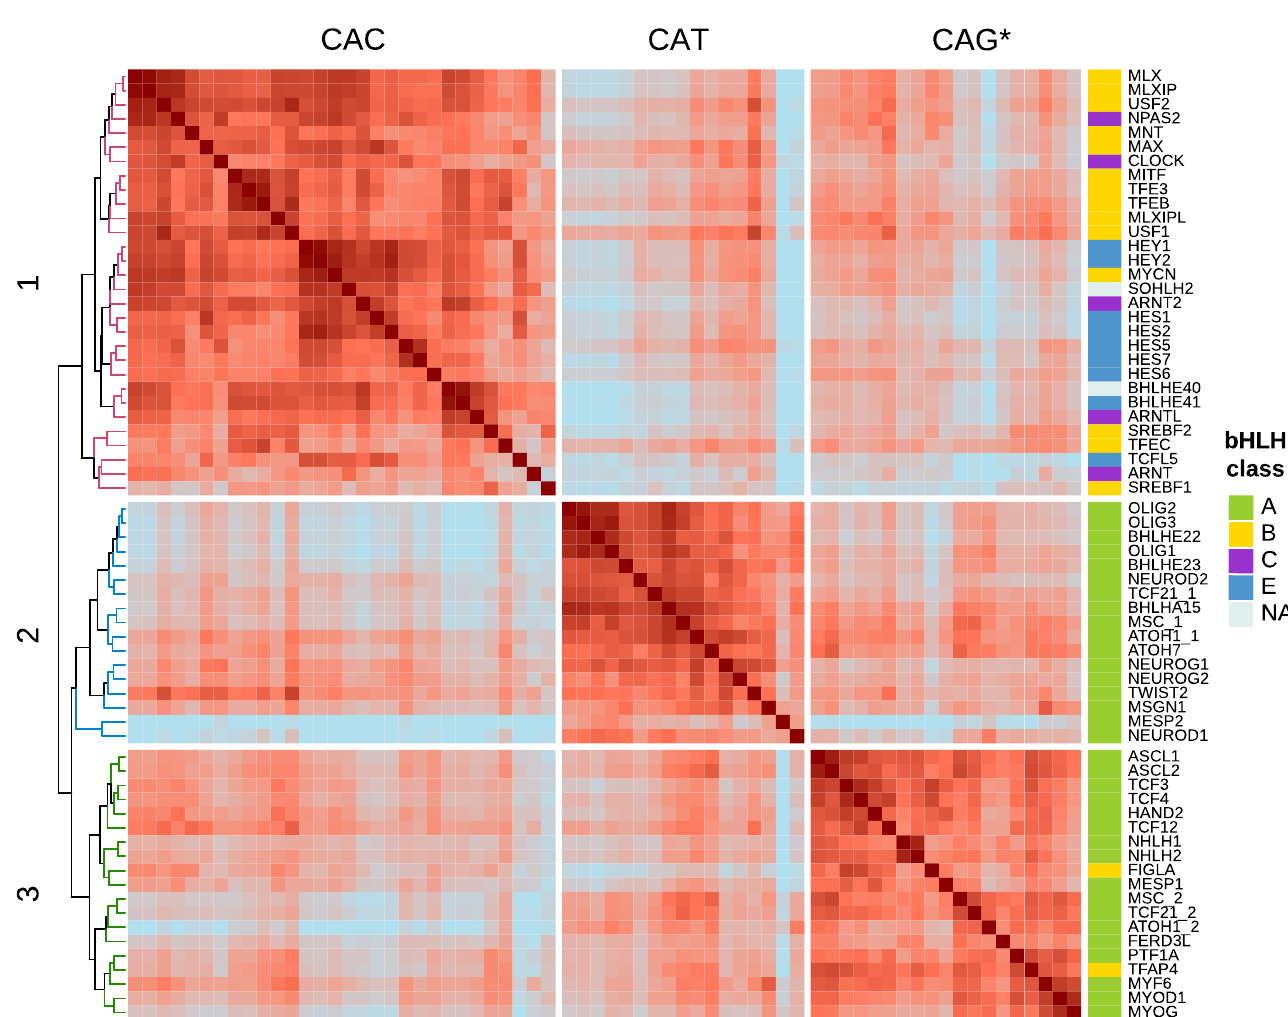
Figure 2. Heatmap representing motif similarity values among bHLH TFs calculated in Lambert et al. [1] from data derived from high-throughput in vitro assays of bHLH homodimers. Hierarchical clustering identifies three groups with a preference for E-boxes containing CAC (cluster 1, red), CAT (cluster 2, blue) and CAG half-sites (cluster 3, green). Homodimers of clusters 1 and 2 bind symmetrical CAT-CAT or CAC-CAC E-boxes, while members of cluster 3 require the presence of CAG in at least one of the half-sites (this difference is indicated by *). A TF can appear in multiple clusters if it is represented by multiple annotated motifs, but when all of them belong to the same cluster, the TF is only shown once. bHLH classes determined by Atchley and Fitch [15] and Ledent et al. [16] are shown on the right column.